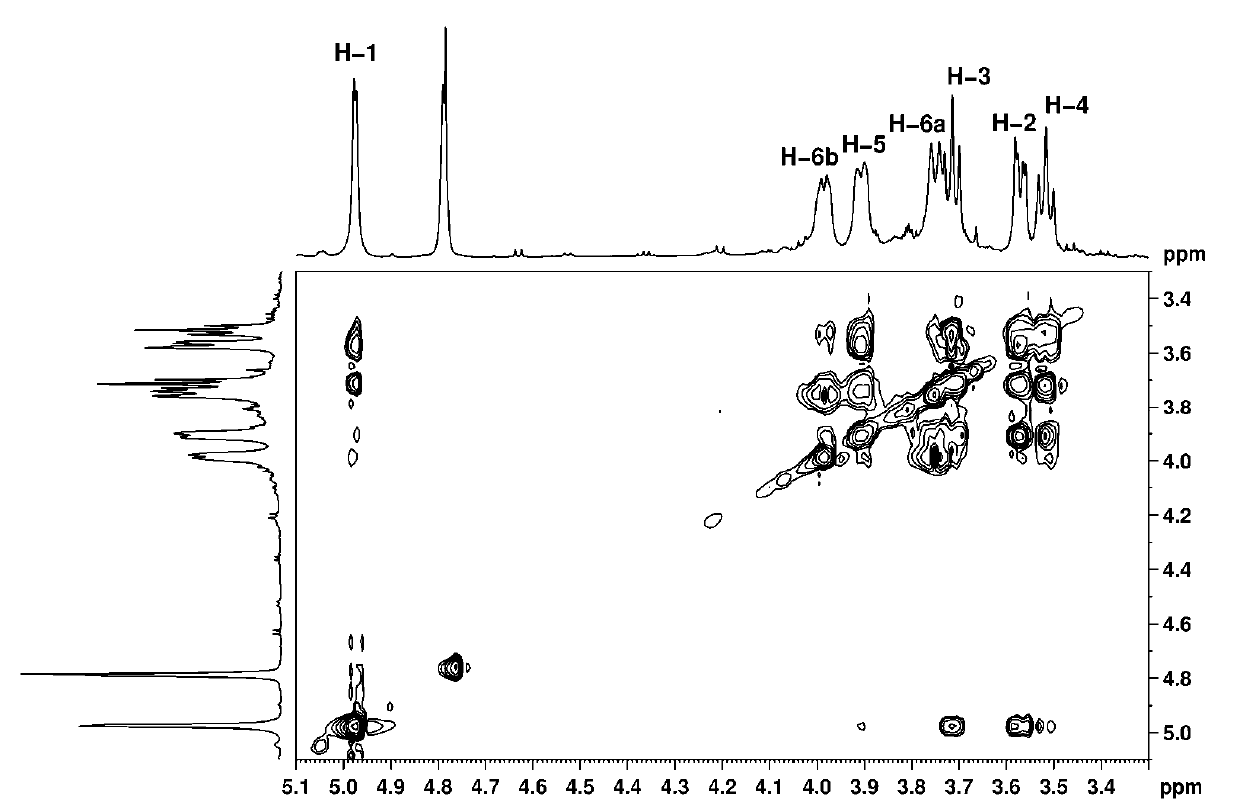
Figure 5. The H, H TOCSY spectrum corresponding to sample M3C4, showing the couplings between the protons belonging to the same spin systems.